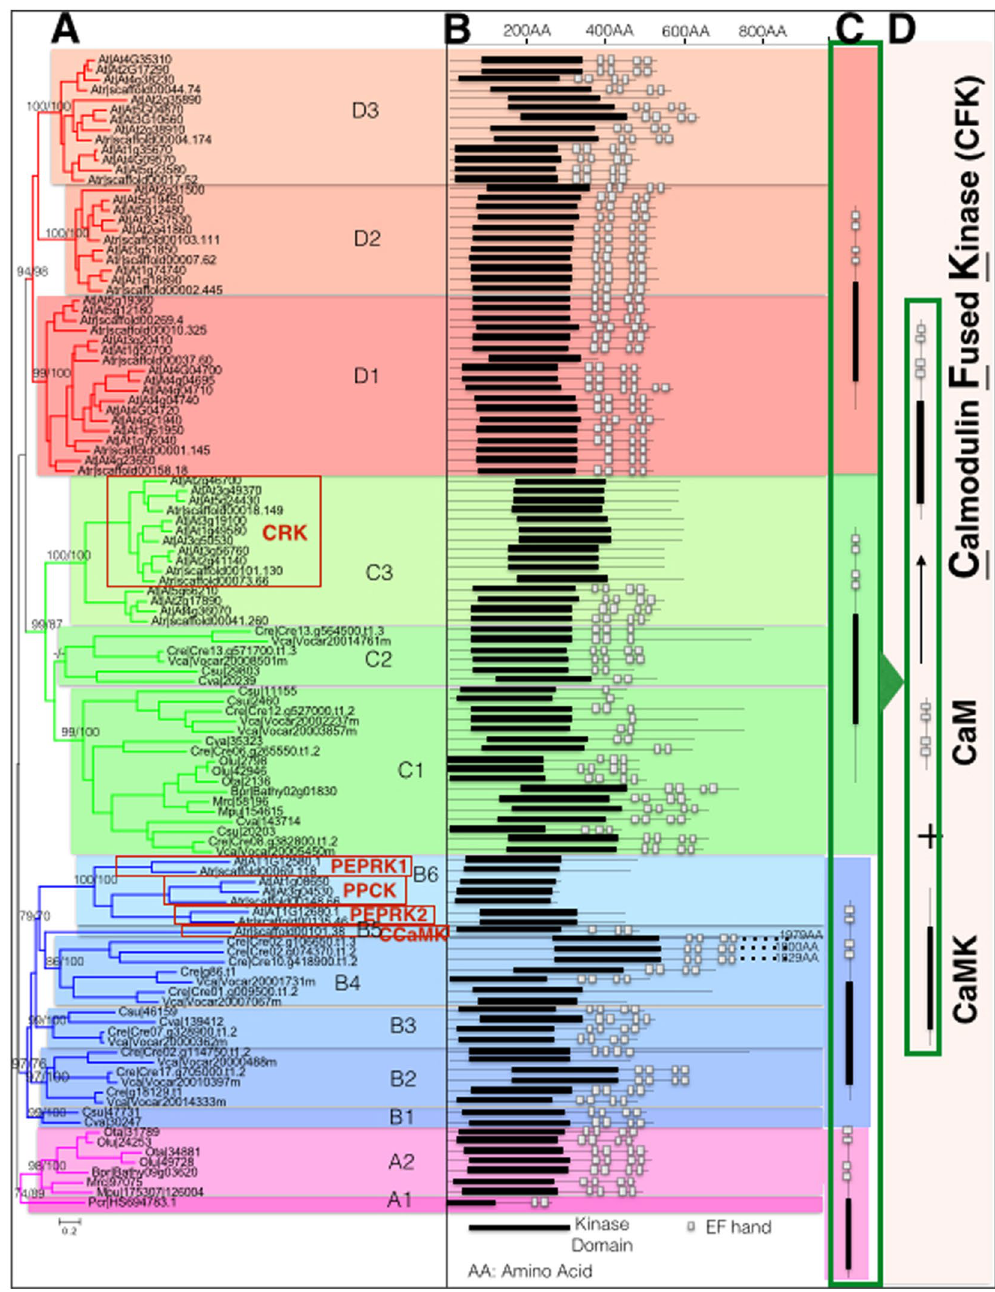
Figure 2. The X monophyly members originated from a single ancestor. ( A ) The X monophyly is divided into four subfamilies ( A–D ) and further subdivided into 14 groups according to the rooted tree using the subfamily A as the root group. ( B ) Protein structures of X monophylic members with kinase domain (solid black bar) and calmodulin-like domain (each small open square represents an EF hand). ( C ) Summary of diagrammatic structures of early branches in each subfamily, ( D ) the entire X monophyly originated from a presumed fusion of a kinase and a